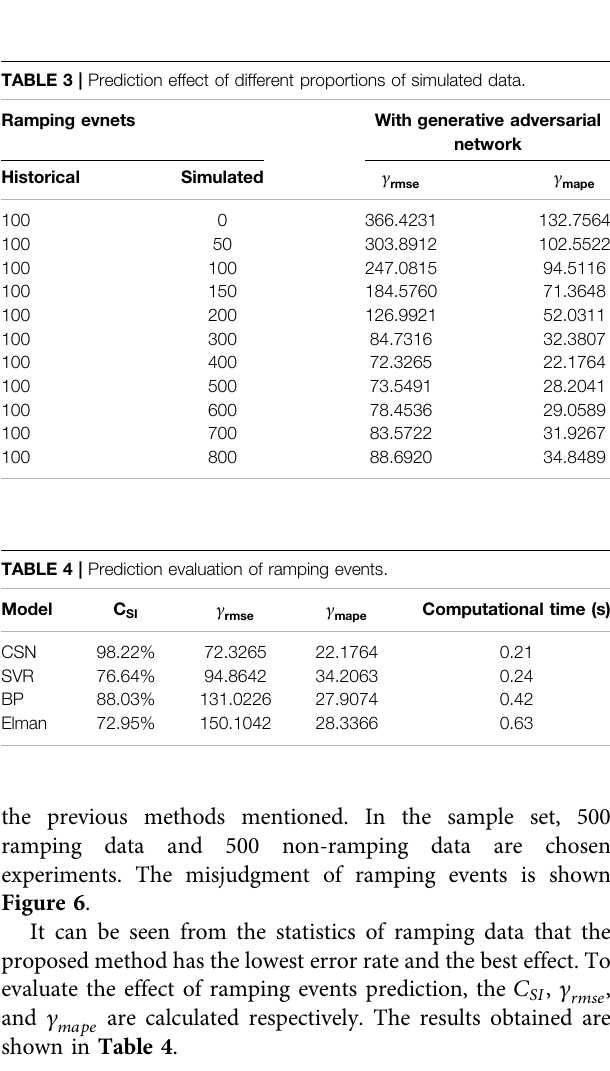
FIGURE 7 | Comparison of power waveform prediction.